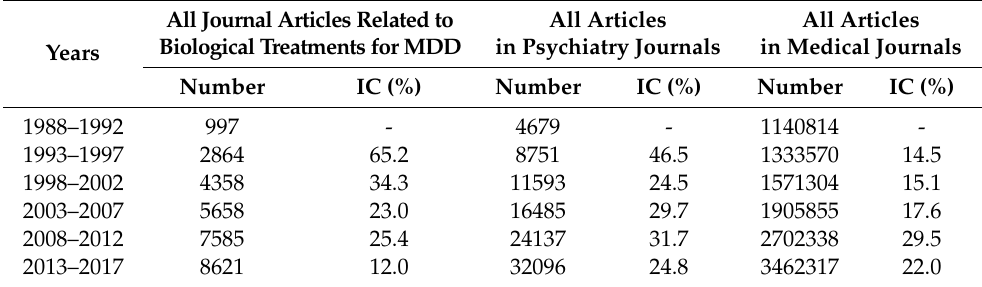
Table 4. The index of change (IC) for journal articles on biological treatments of major depressive disorder in psychiatry and medical journals from 1988 to 2017.